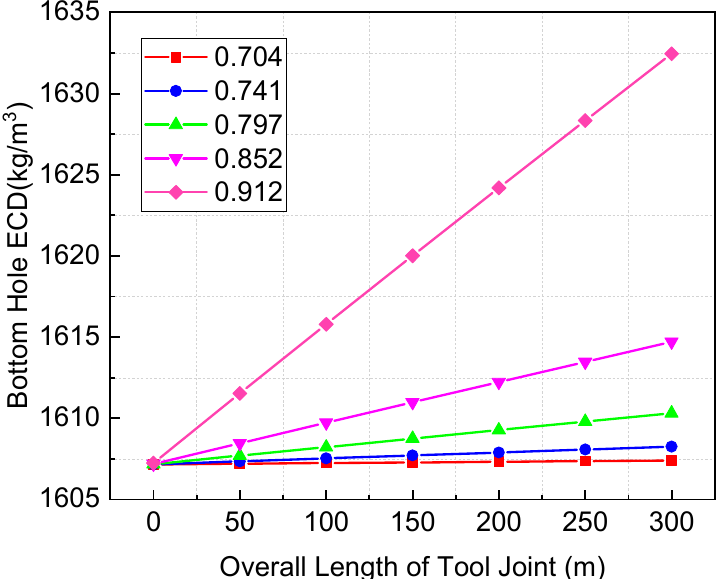
Figure 17. Bottom hole ECD vs. overall length of tool joint.